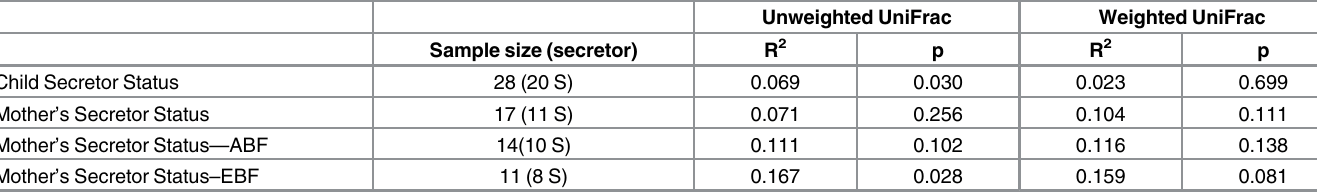
Table 2. Effect of secretor status on children ’ s unweighted and weighted UniFrac